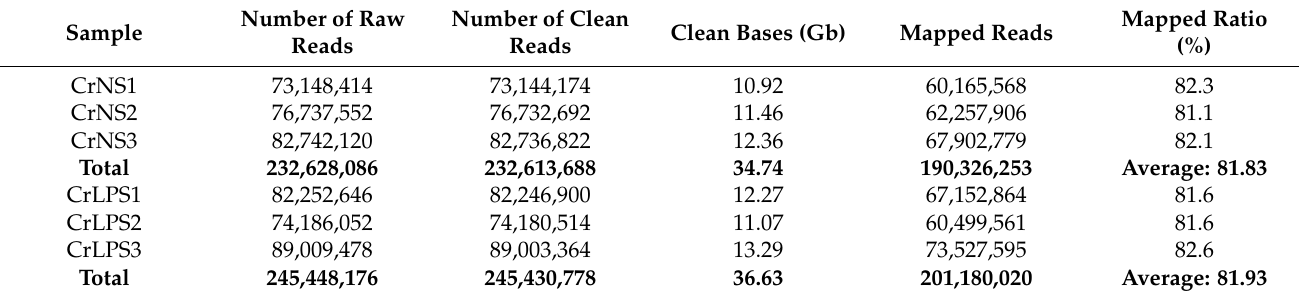
Table 1. Statistics of the horseshoe crab C. rotundicauda RNA-seq data.